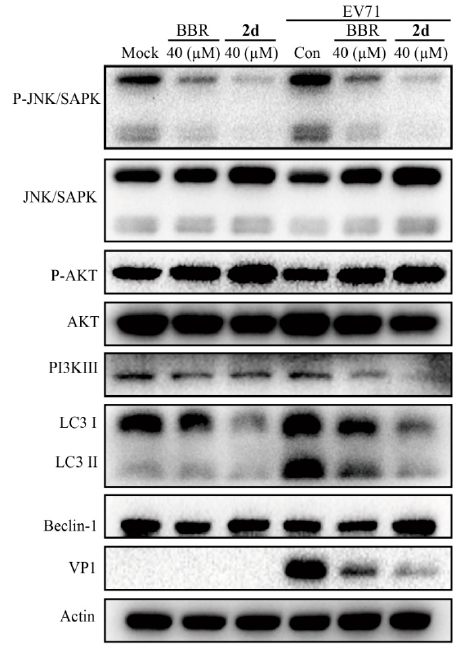
Figure 4. Compound 2d inhibits EV71-induced autophagy. Vero cells were mock-infected or infected with EV71 (H, MOI = 0.1) for 1 h. The cells were then treated with compound 2d and BBR for 24 h. The cells were harvested and proteins were examined by western blot.